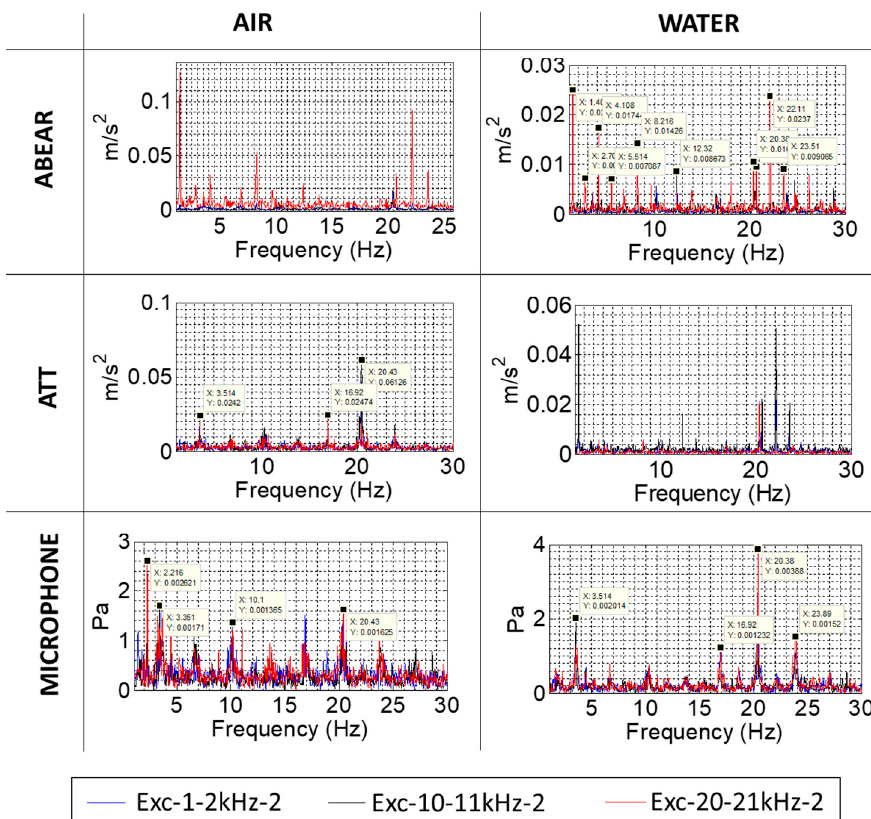
Figure 12. Amplitude demodulation for the sensors on the stationary frame and the excitation with two modulating frequencies. Rotating case ( f f = 4.1 Hz).